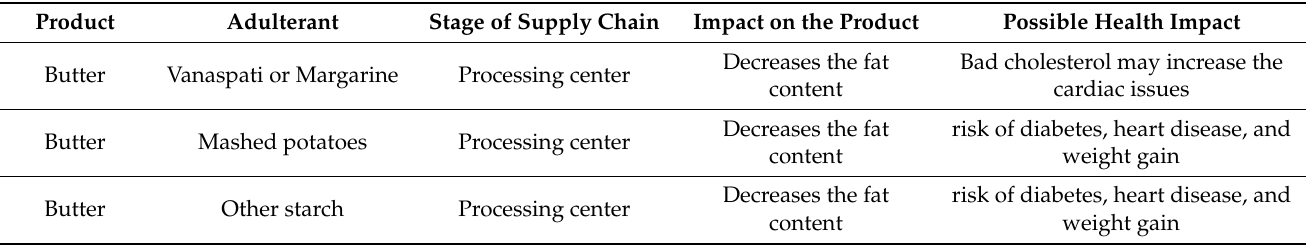
Table A3. Type of adulterants in butter and their impacts on health and nutrition.